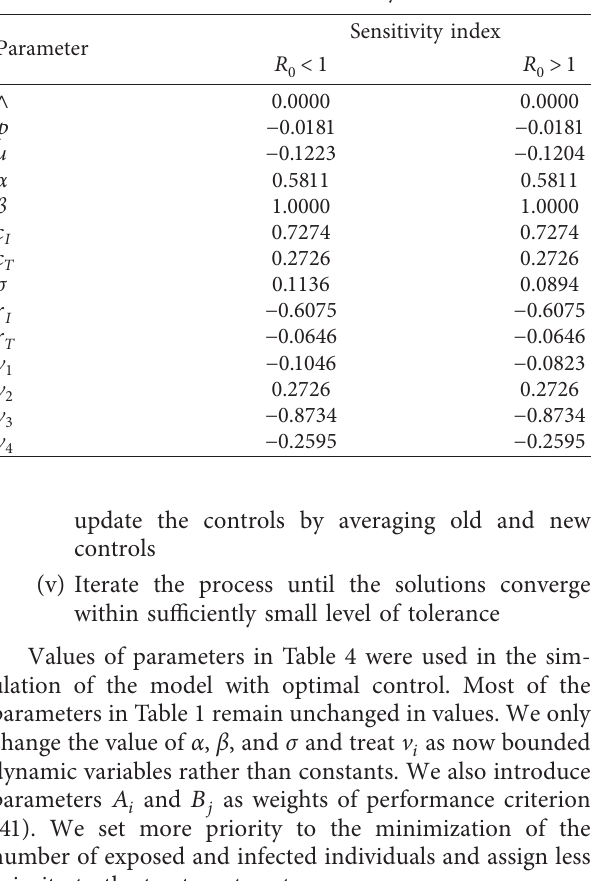
Figure 2: The dynamics of human population when (a) R Table 3: Parameter sensitivity index. Table 4: Parameter values for the model with optimal